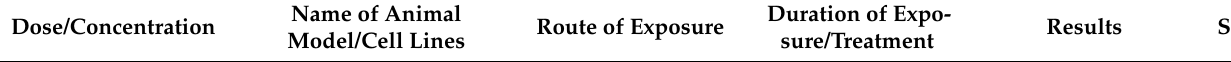
Table 9. Effects of curcumin on mercury toxicity based on doses, experimental methods, and